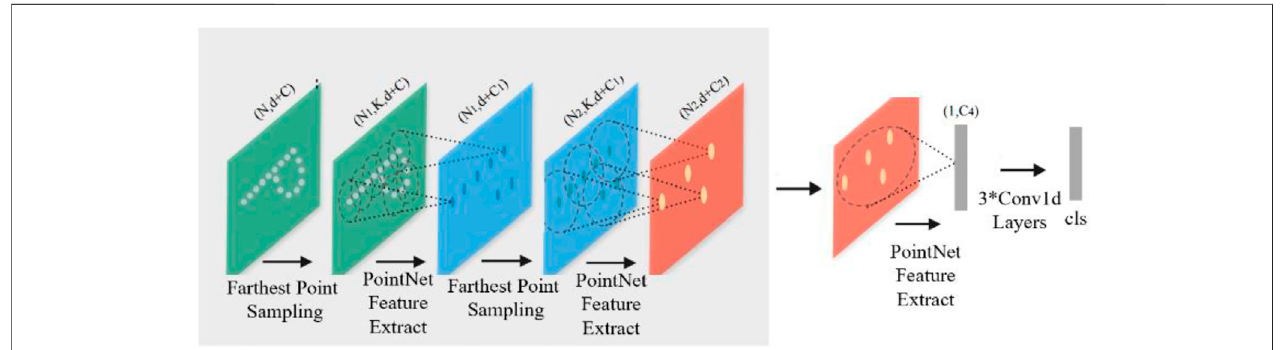
FIGURE 1 | Diagram of the improved